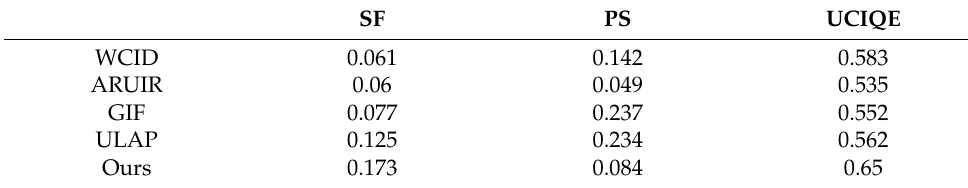
Table 4. Quantitative analysis of Figure